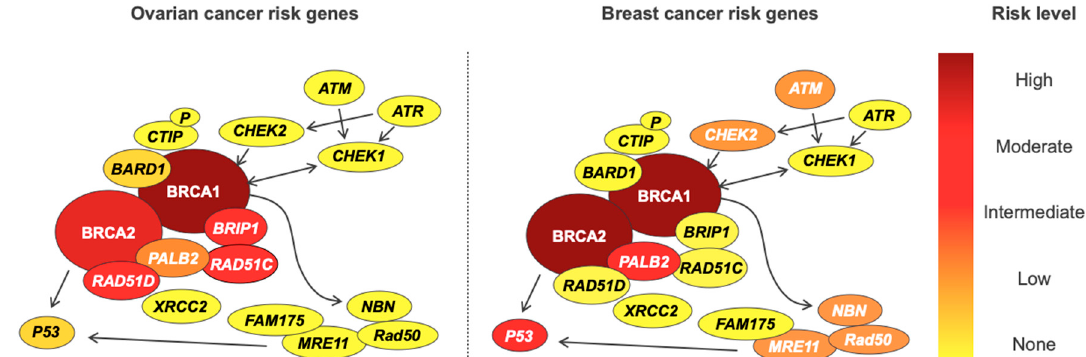
Figure 1. Susceptibility genes present in the double-strand DNA break repair pathway for ovarian and breast cancer and its different correspondent risks levels in each disease.